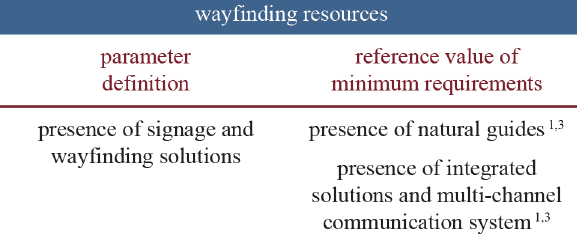
Table 3. Proposed parameters for the assess of wayfinding resources. Sources are 1: Italian regulation, 3: literature and empirical